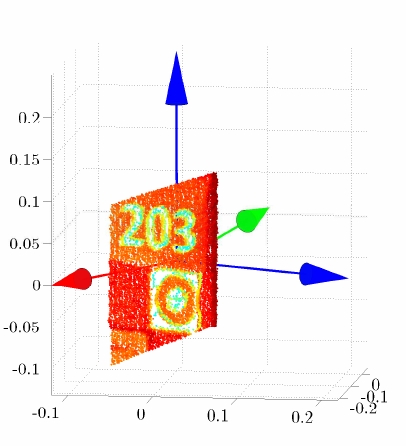
Figure 2: Raw point cloud colored by intensities, red vector is plane normal ~n , blue vectors ( ~e 1 , ~e 2 ) strain the plane and green vector is the direction of incidence laser beams ~v Table 1: Precisions of unit vectors defining the reference plane The precision of parameter d from equation of a plane (1) equals σ = 0 . 06 mm. The incidence angle of laser beams d on to a reference plane equals ϕ = 66 . 3 ◦ . In the Figure 3 points projected on to the plane and the obtained raster image are presented. Note that scan lines are visible due to oblique projection. If orthogonal pro- jection was performed the scan lines would be blurred, if visible at all.